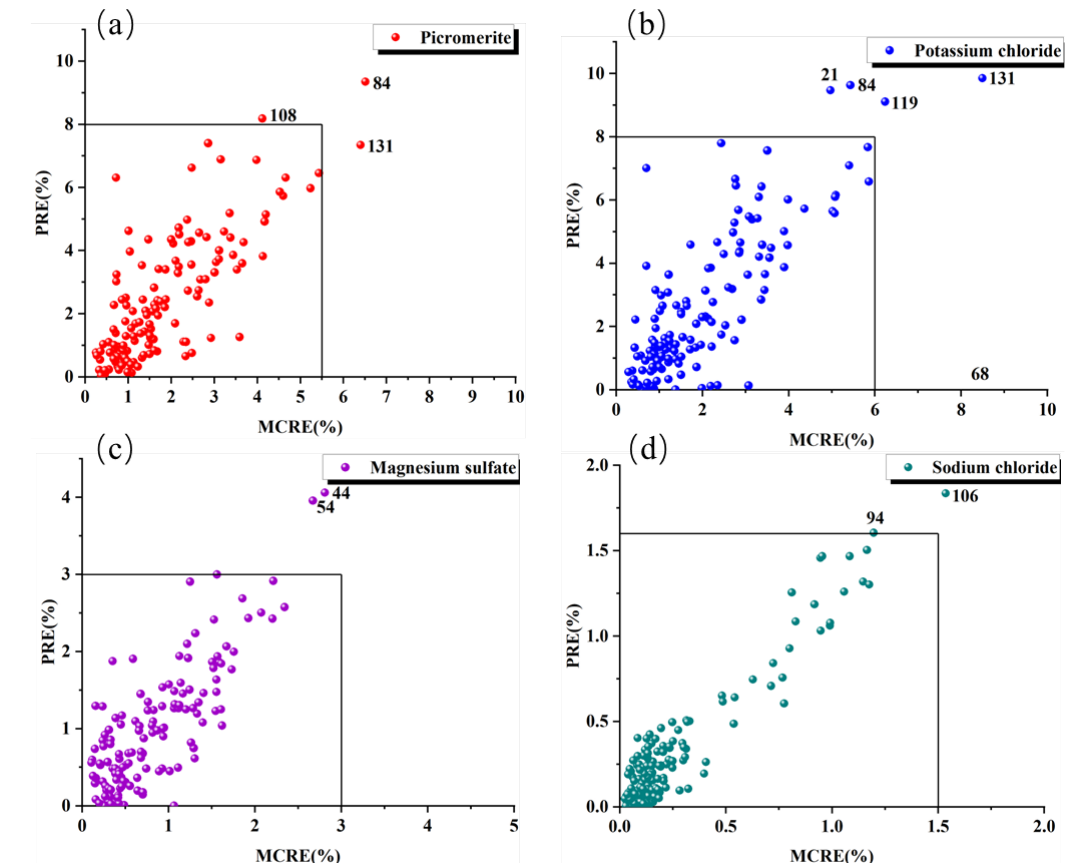
Figure 7. Anomalous sample detection of four minerals in MP samples. ( a ) picromerite content was used as the response variable; ( b ) potassium chloride content; ( c ) magnesium sulfate content; ( d ) sodium chloride content.